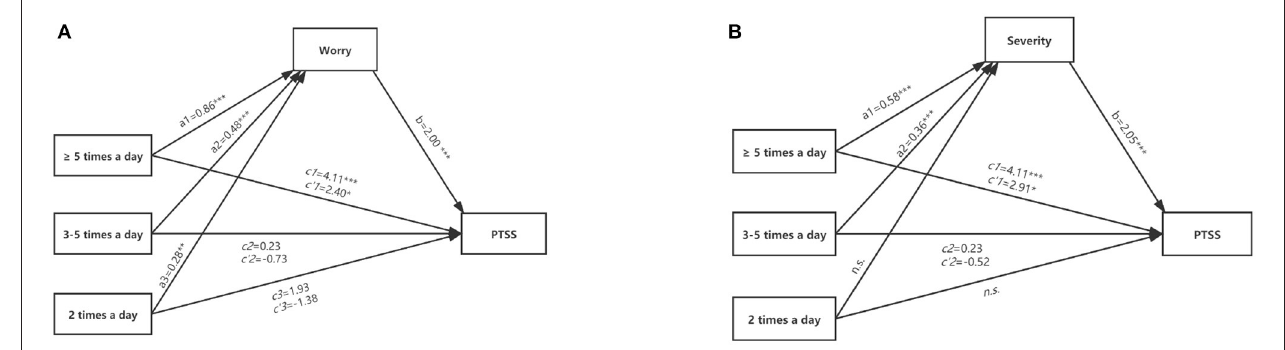
FIGURE 1 | The mediation models of risk perception. (A) Depiction of the mediation model where risk perception (worry) mediates the relation between media exposure and PTSS; (B) Depiction of the mediation model where risk perception (severity) mediates the relation between media exposure and PTSS. a1-a3 and b, unstandardized coefficient; c’1-c’3, unstandardized coefficient after controlling mediators. n.s., the mediating effect of “2 times a day” on PTSS through “severity” was not significant. *** p < 0.001, ** p < 0.01, * p < 0.05. not include 0). The relative indirect effect test indicated that two relative indirect effects were significant (95% CI did not include 0). Thus, compared to the reference group, the subgroup consuming COVID-19 media more than five times a day perceived as 0.58 units more severity of the COVID-19 ( a 1 = 0.58), the subgroup consuming COVID-19 media 3–5 times a day perceived as 0.36 units more severity ( a 2 = 0.36), Furthermore, holding condition constant, those who perceived more severity of the COVID-19 also had higher PTSS scores ( b = 2.05) ( Figure 1B ). The relative indirect effects of “severity” were a 1 b = 1.19; a = 2 b